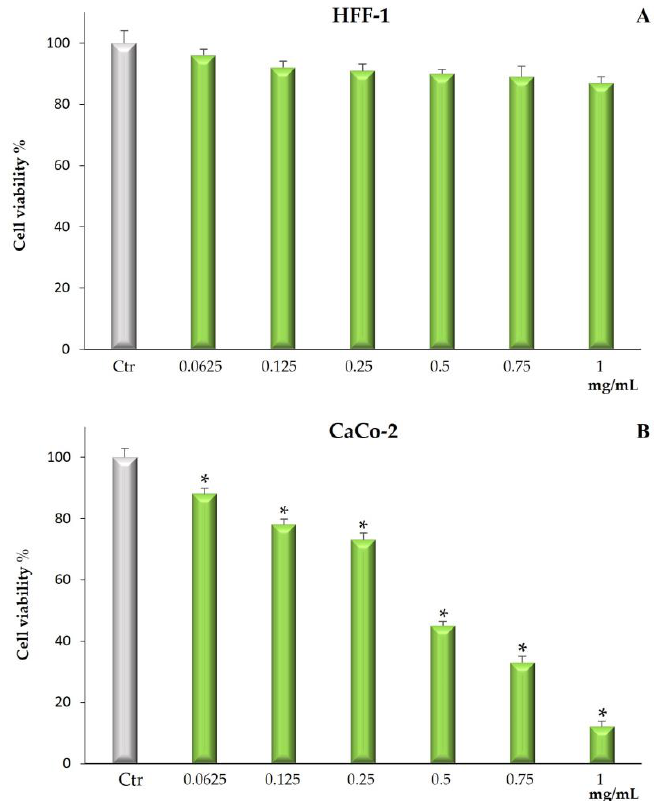
Figure 3. Cell viability in HFF-1 ( A ) and CaCo-2 ( B ) cells untreated and treated for 72 h with Bff -EAF at different concentrations (0.0625–1 mg/mL). Values are the mean ± SD of four experiments in triplicate. * Significant vs. untreated control cells: p < 0.001.